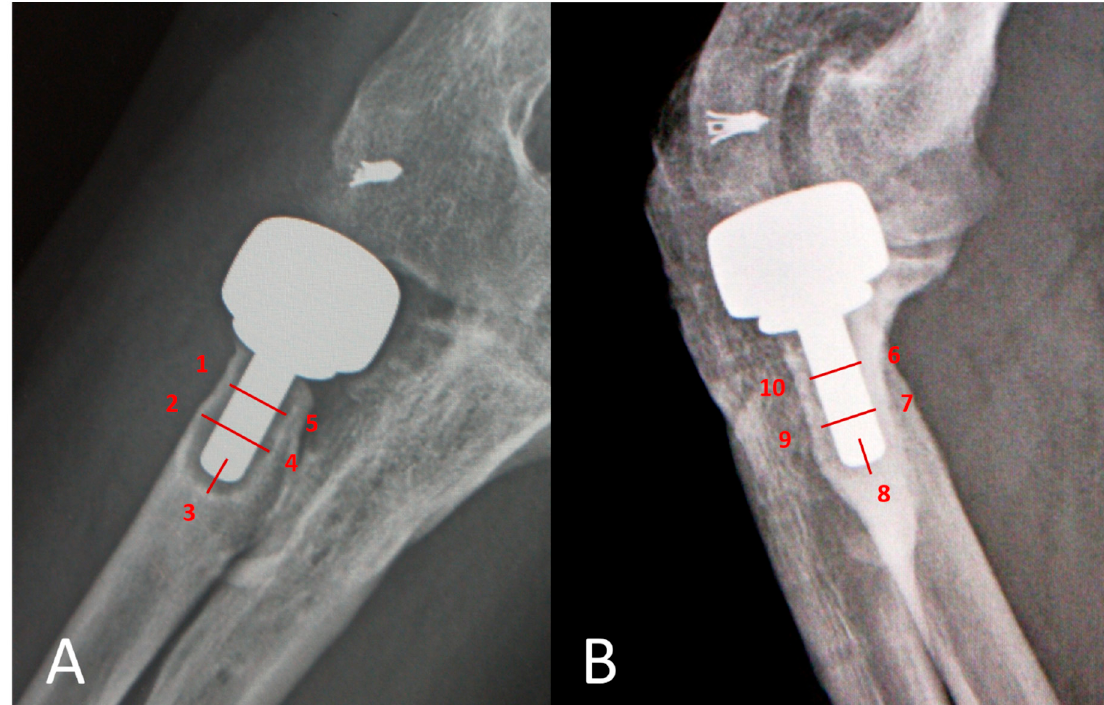
Figure 2. Prosthesis-cortical interface is divided into 5 zones in ( A ) anteroposterior view (zone 1 to 5) and ( B ) lateral view (zone 6 to 10) respectively.